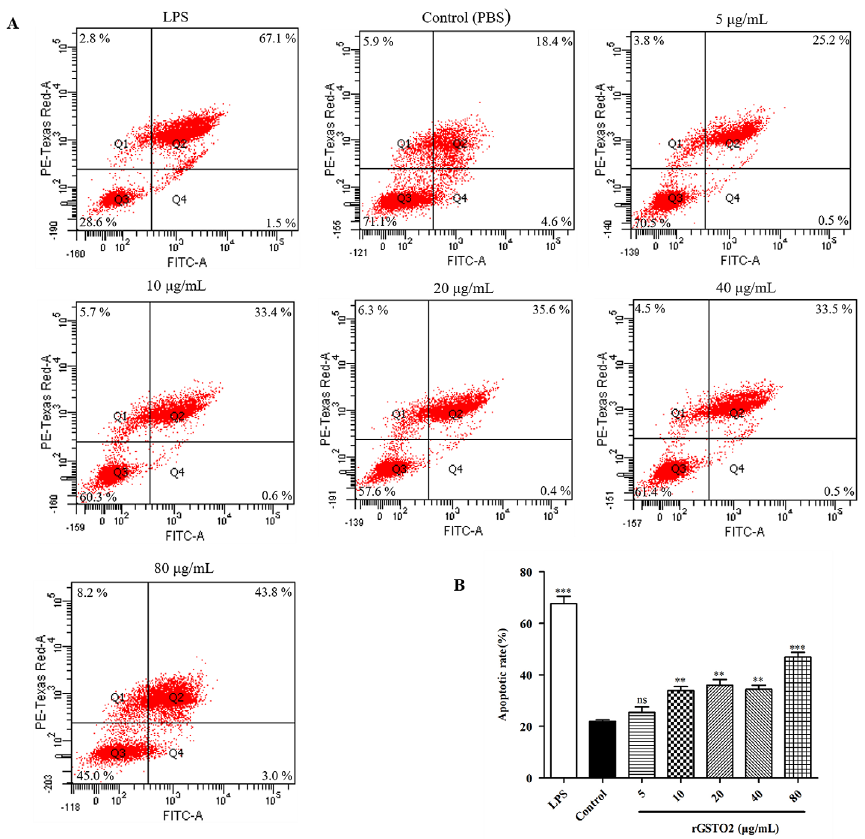
Figure 6. Effects of rGSTO2 on apoptosis of RAW264.7 macrophages. (A) RAW264.7 macrophages were stimulated with rGSTO2 and then stained with Annexin V and propidium iodide (PI), followed by the detection of apoptosis using fl ow cytometry. (B) Apoptosis rate of RAW264.7 macrophages stimulated by different concentrations of rGSTO2; Ns means that the difference is not signi fi cant, ** p < 0.01 and *** p < 0.001 indicates a signi fi cant difference compared to the control group. All data are expressed as means ± SD ( n =